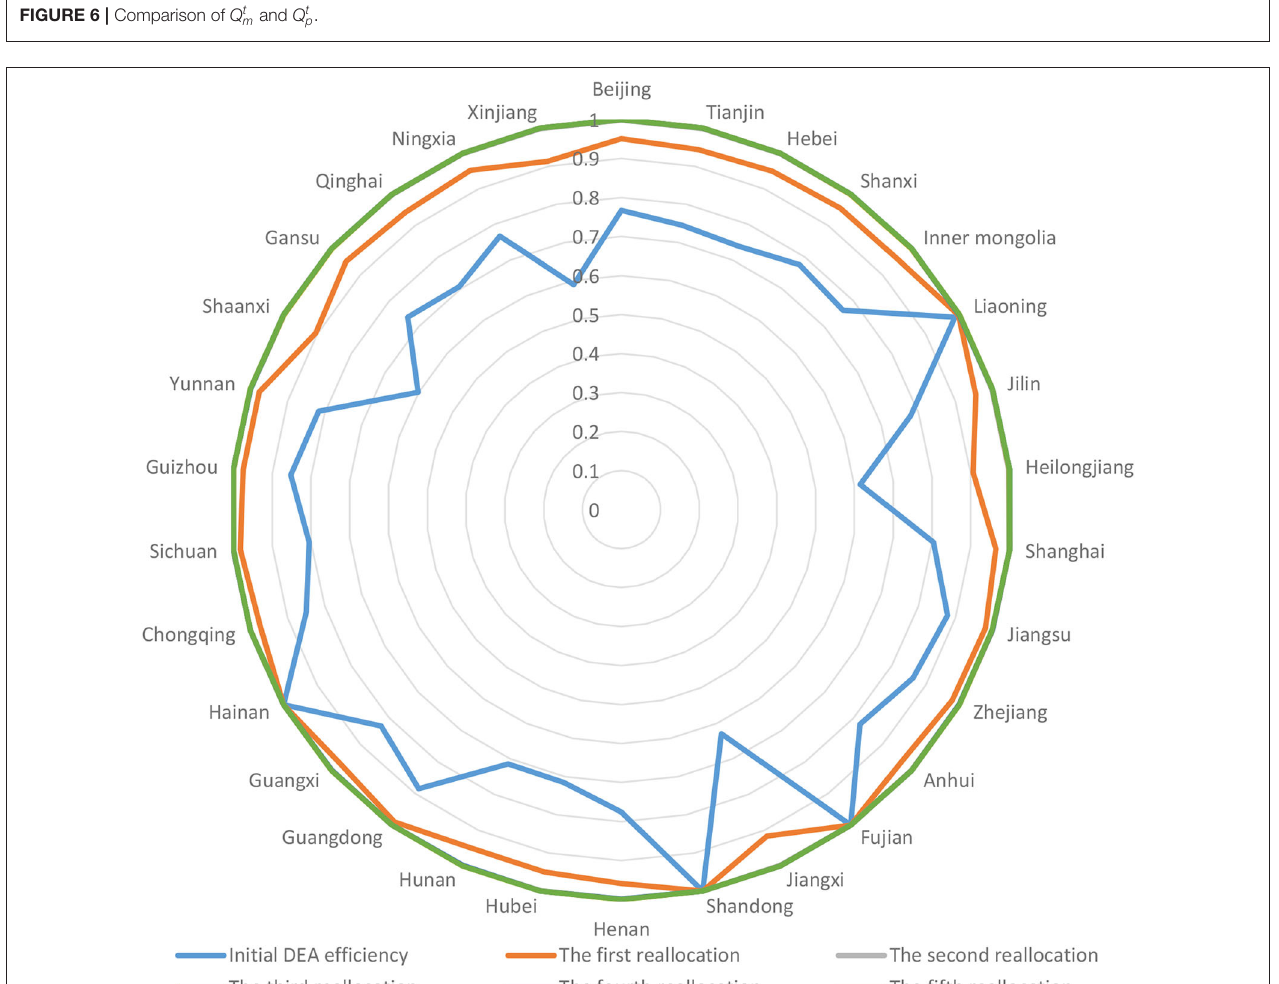
FIGURE 7 | The evolution of the DEA efficiency value.